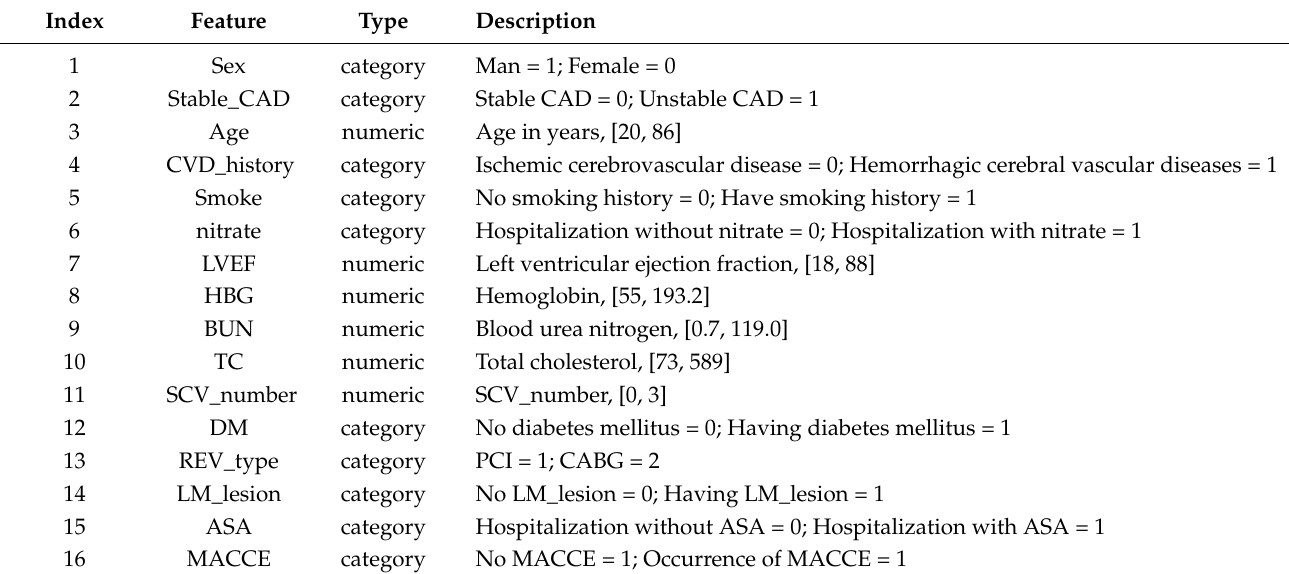
Table 1. Description of Features.